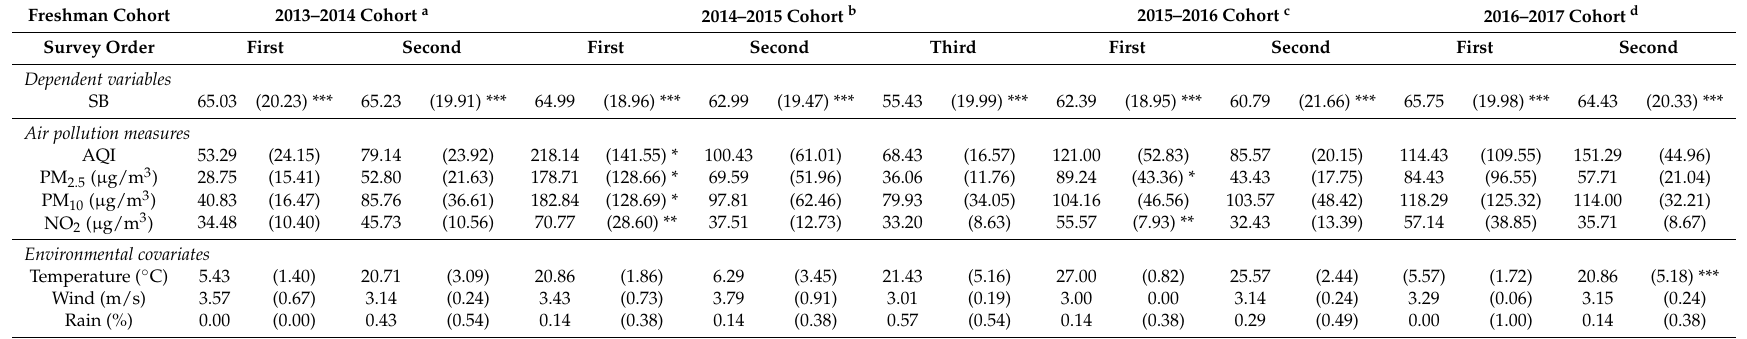
Table 2. Average SB, air pollution concentrations, and other environmental variables in the last seven days before the survey.